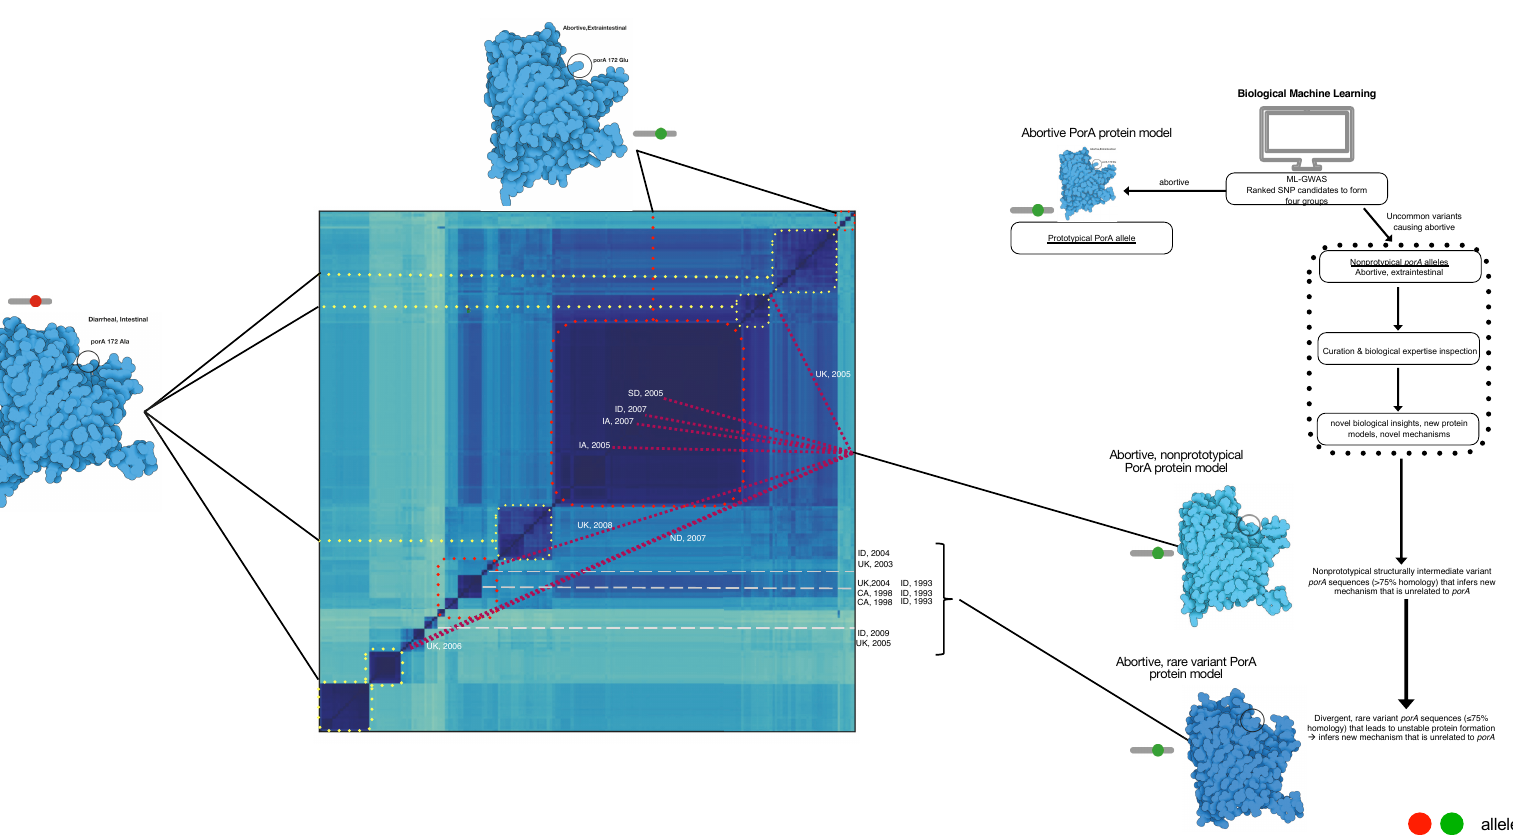
Figure 4. Whole-genome distance matrix using MinHash depicting an all-against-all comparison of genome diversity for all isolates used in this study overlaid with the porA variant associated with body location and disease phenotype. Genotypes and porA alleles are connected in this depiction to examine the association between intestinal / diarrheal location (yellow dot boxes), prototypical extraintestinal / abortive (red dot boxes), non-prototypical porA alleles in extraintestinal / abortive (maroon lines), and rare porA variants in extraintestinal / abortive (grey dashed lines) were co-located to their respective genomes in the genotype map. For the non-prototypical variants, the year and location of isolation was included to depict the variation over time and space in the maintenance of a minority population of porA alleles of extraintestinal abortive C. jejuni . The diagram to the right depicts the process used for this